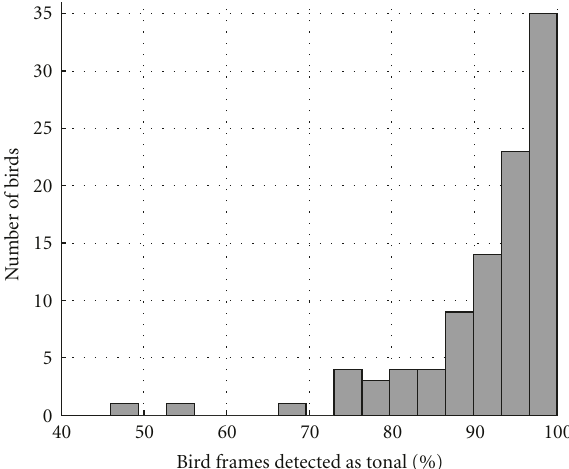
Figure 3: Histogram of the number of birds having the given percentage of bird signal frames detected as tonal on clean data.